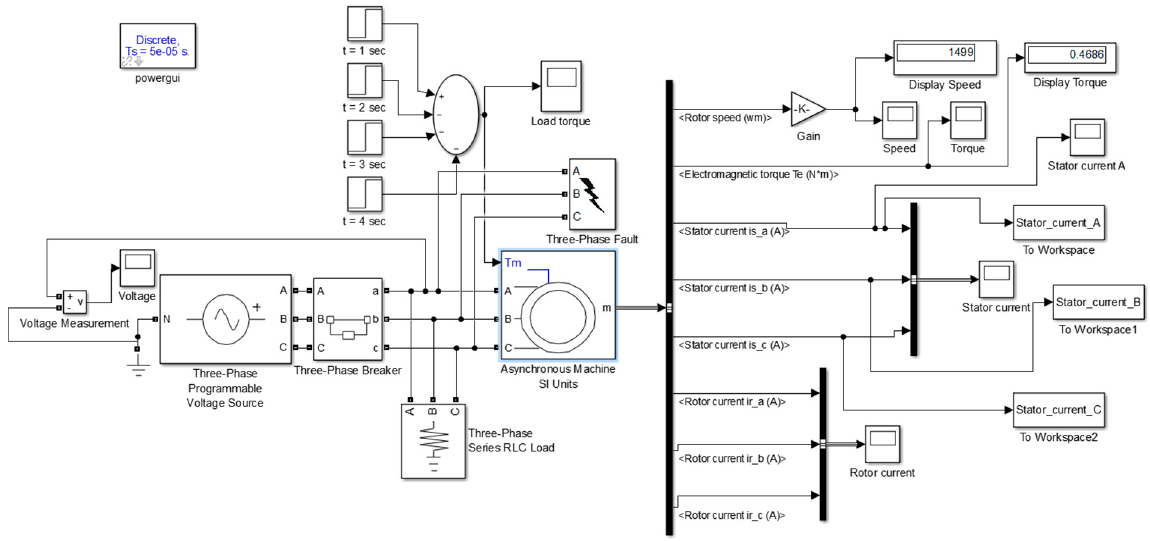
Figure 1. Simulation model in MATLAB Simulink. Table 1. Parameters of the IM and block of fault.